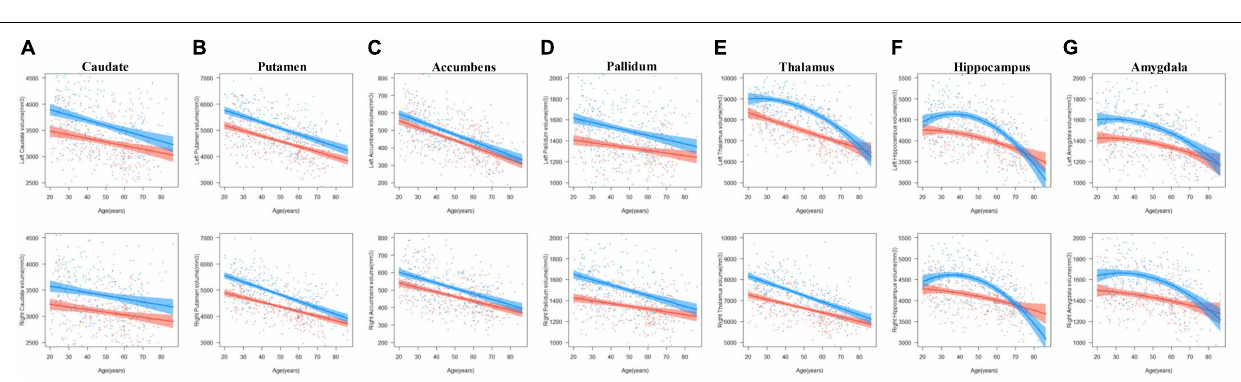
FIGURE 4 | The age trajectories of left (upper layer graph) and right (lower layer graph) subcortical volumes, including the (A) caudate, (B) putamen, (C) accumbens, (D) pallidum, (E) thalamus, (F) hippocampus, and (G) amygdala in females (red color) and males (blue